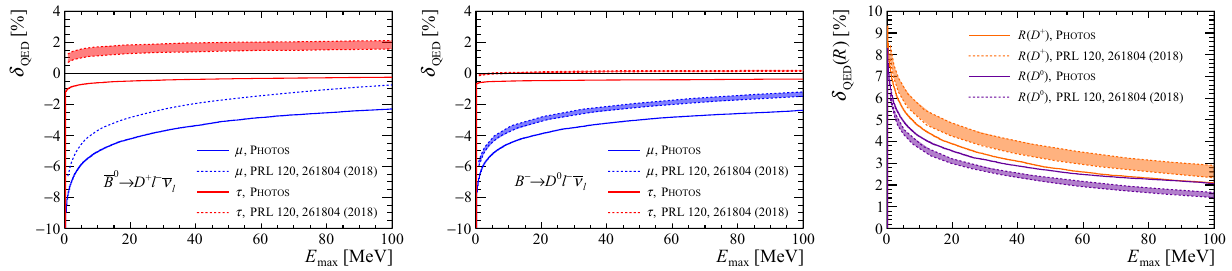
(solid lines, which include the statistical uncertainty) and from Ref. [9] (dashed lines, filled with transparent colours when the uncertainties are